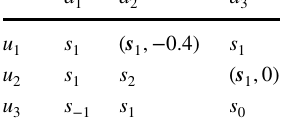
Table 2 FLC ( U , A , S ∗ , R ∗ )